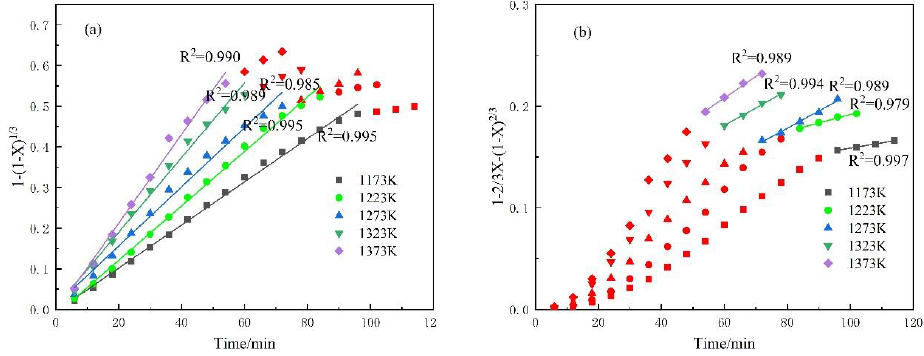
1 1 3 vs time and ( b ) 1 − 3 vs time and ( b ) 1 −